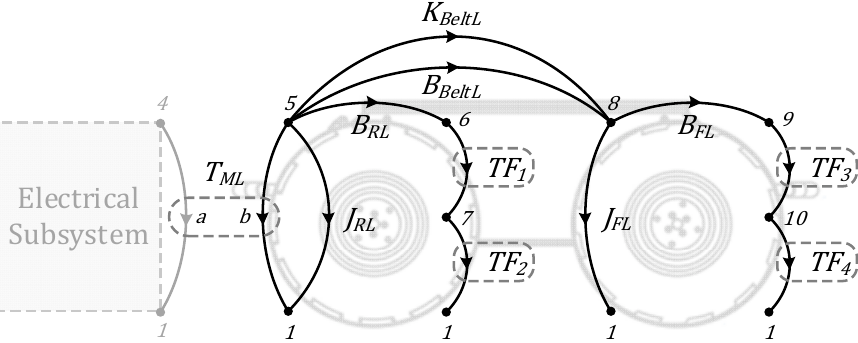
Figure 5. LG model of the left-side drivetrain subsystem overlaid on the profile of the Husky robot. For the simplified model, it is assumed that the belt is not flexible, thus eliminating the compliance between the primary and secondary axles of the drivetrain. With this change, the model can be further simplified by combining the inertia of the primary and secondary axels into a single element ( J L ) as shown in Figure 6.